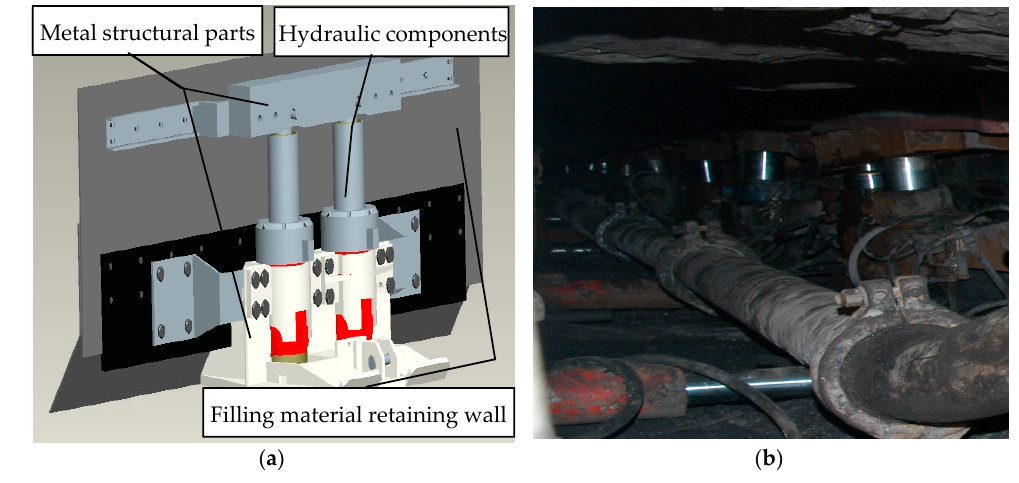
Figure 9. Retaining support: ( a ) Schematic diagram; ( b ) Pictures.